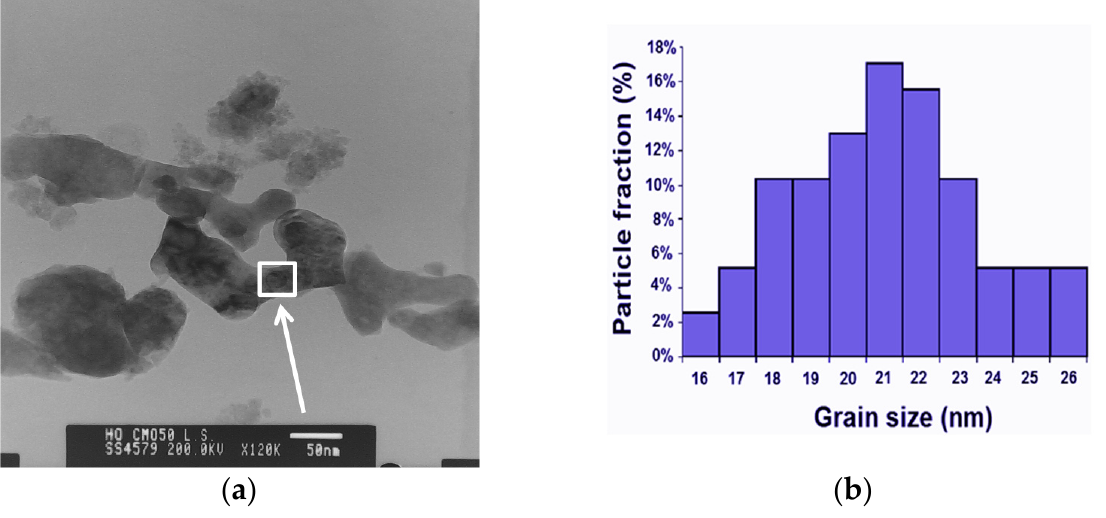
Figure 2. ( a ) High-resolution transmission electron microscopy image showing several agglomerates of nanoparticles. The white square indicated by the arrow highlights a single nanoparticle; ( b ) grain size distribution of the nanoparticles.